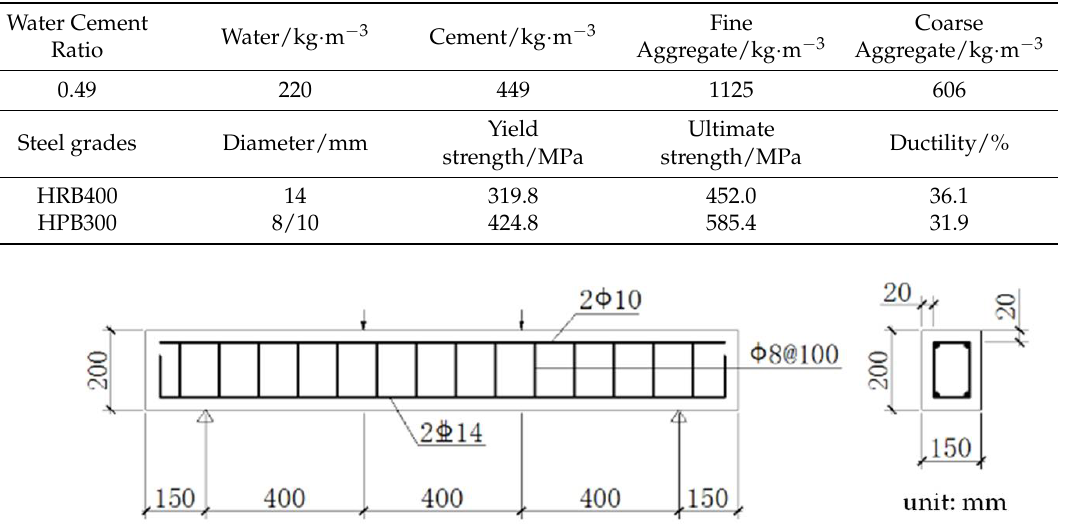
Figure 4. Schematic diagram of RC beam size and reinforcement.